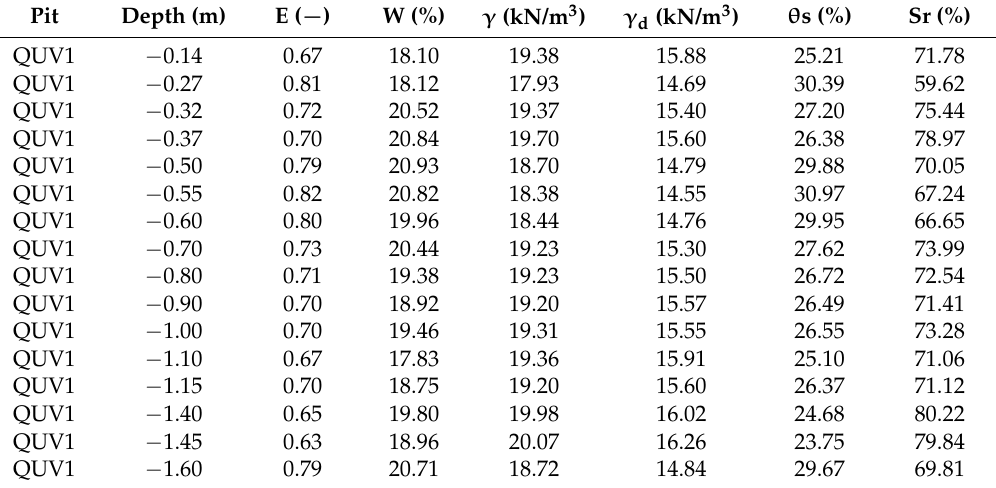
Table 4. In situ characteristics of Santa Maria della Versa test-site (25 August 2017) 1 .